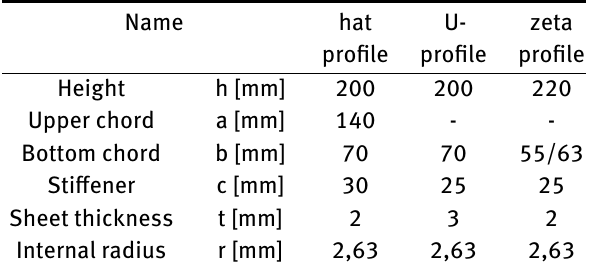
Table 1: Dimensions of analysed